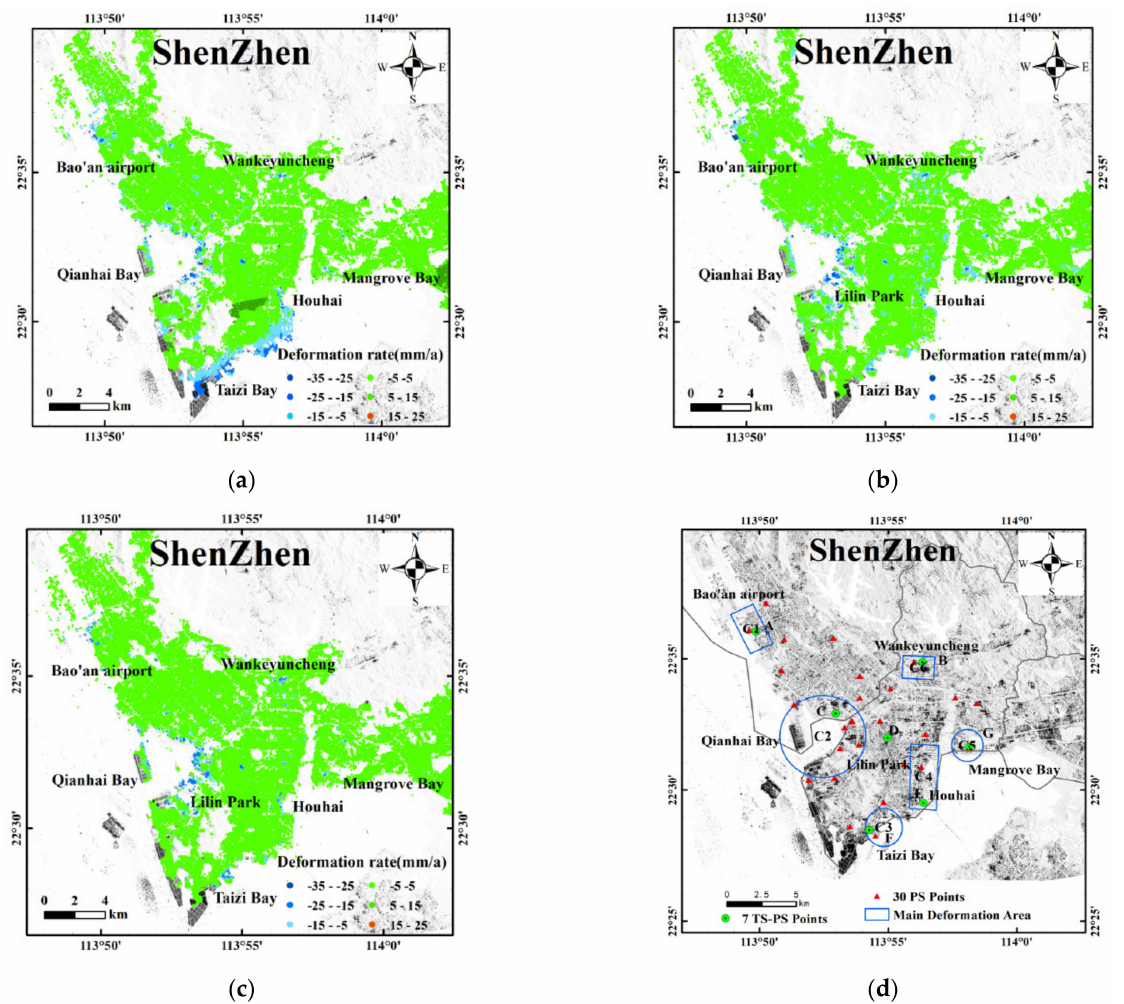
Figure 12. Vertical deformation rates based on ( a ) the spatio–temporal baseline threshold method ( b ) the manual method ( c ) the ResNet50-DCNN method. ( d ) Distribution of the main subsidence areas (C1–C6) and the permanent scatter points (PS). Points A–G: Time series of specific PS points (see also Figure